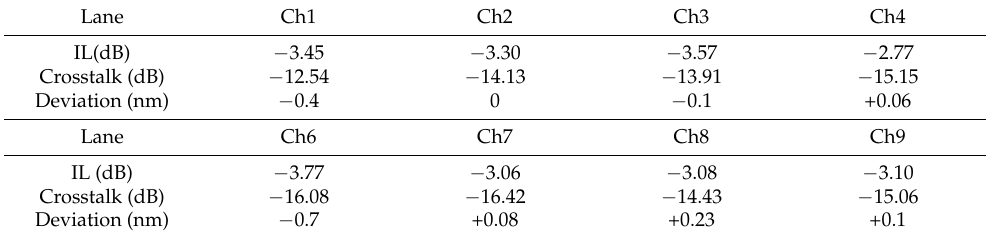
Table 3. Performance of the 8-channel (de)multiplexer.